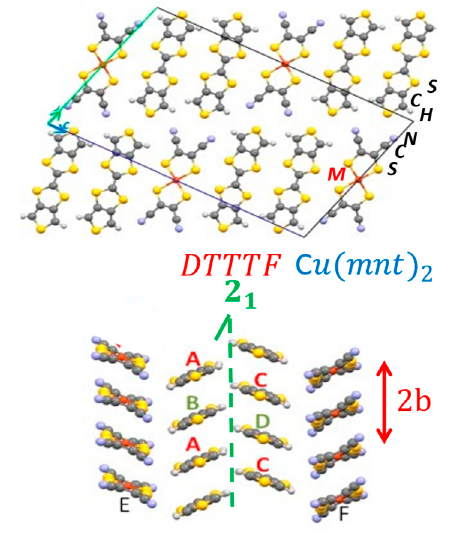
Figure 8. Crystal structure of DTTTF 2 -Cu(mnt) 2 perpendicular to the stack direction (top) and along the stack b direction (bottom), showing the 2 1 -screw axis symmetry between donor stacks in the metallic state. The atoms are labelled in the top figure. The break of 2 1 symmetry below the 4k F transition doubles the b periodicity and leads to a charge disproportion with alternating hole rich (red) and hole poor (grey) donors.